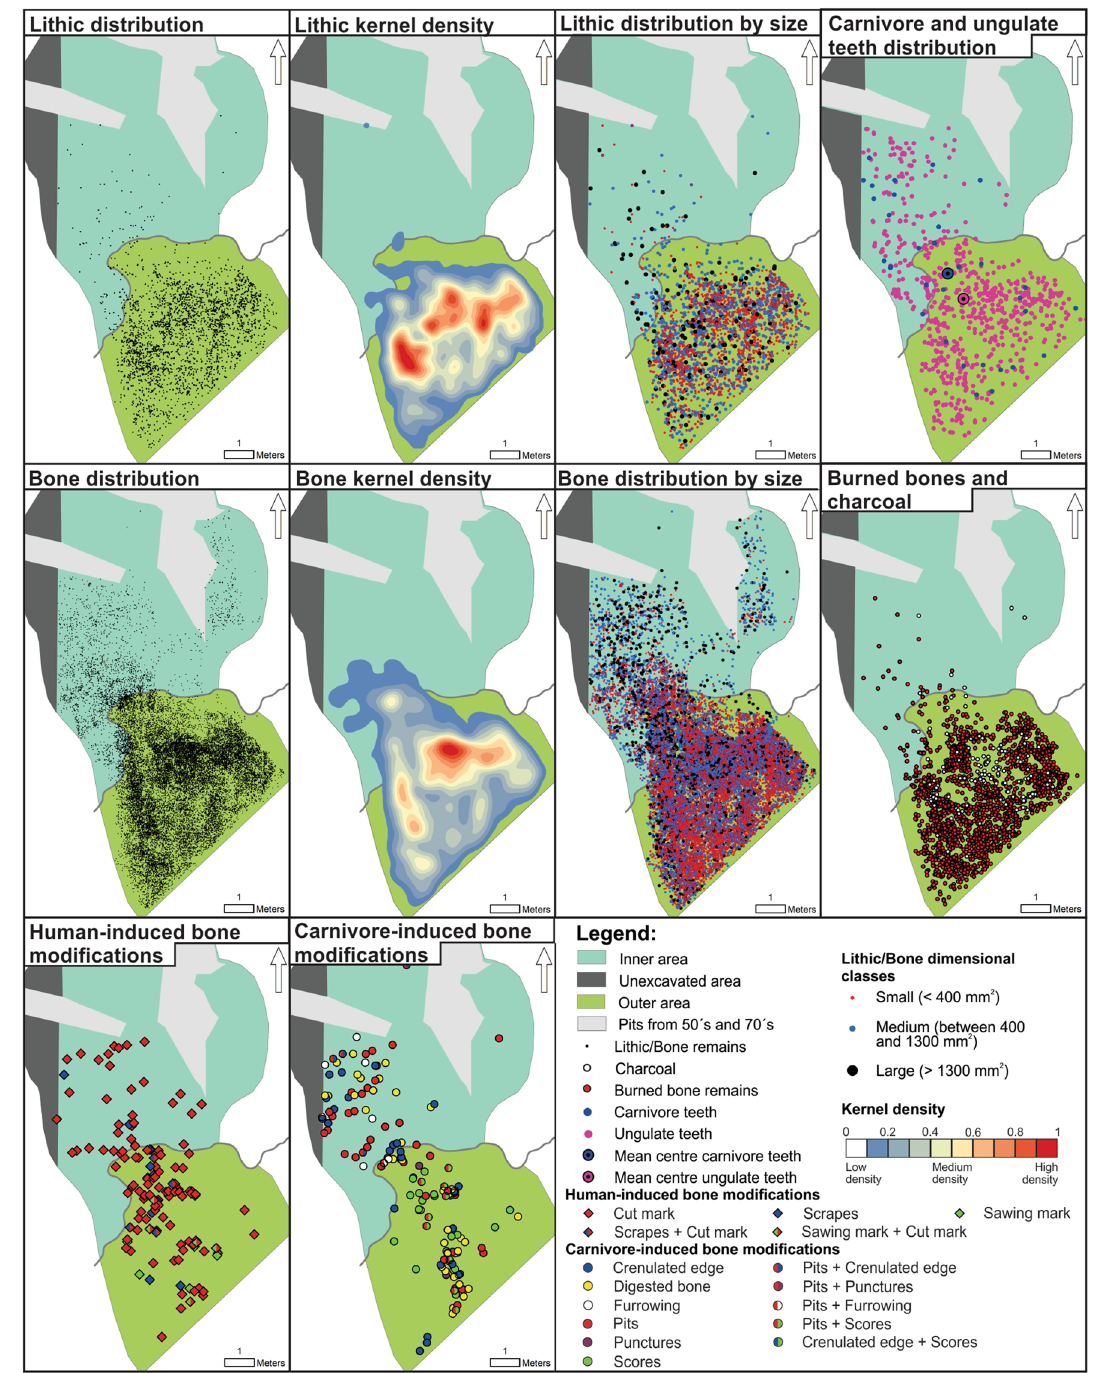
Figure 8. Spatial distribution of lithic artefacts, faunal specimens, burned bones, charcoal, carnivore/ungulate teeth, and human/carnivore-induce modifications on bones from subunit